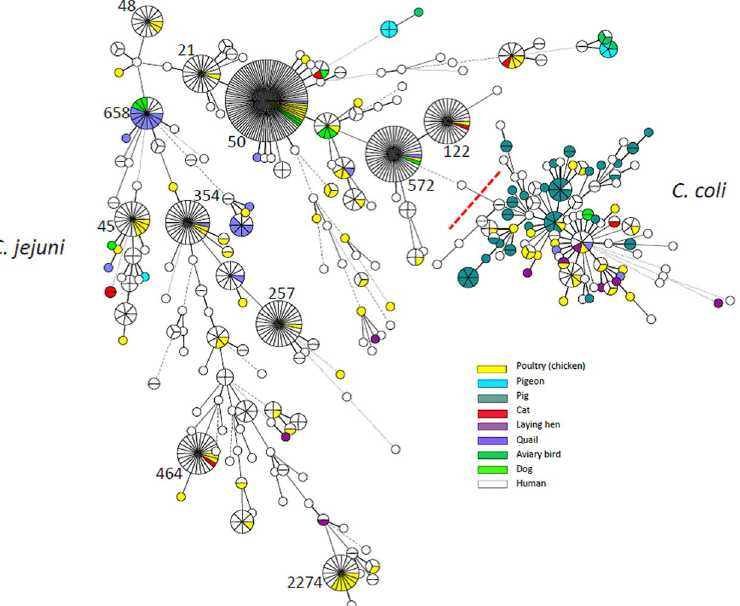
Figure 2. Minimal Spanning Tree generated from MLST comparisons of 816 C. jejuni and C. coli isolates from human study participants and from animals and food samples from the study region. Colouring according to host species as specified in colour legend. Only abundant sequence types (STs) are labelled. A version of the figure with full labelling is available as Supplementary Figure S2.